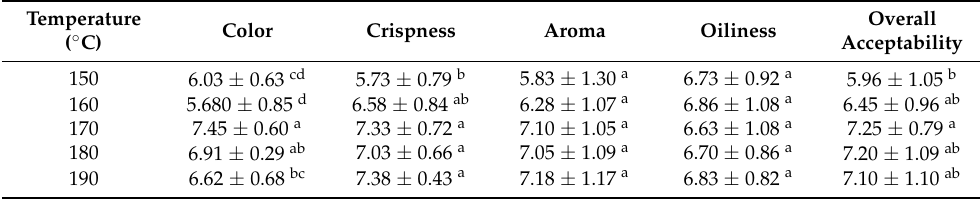
Table 1. Effect of frying temperature on the sensory evaluation of French fries. Temperature ( ◦